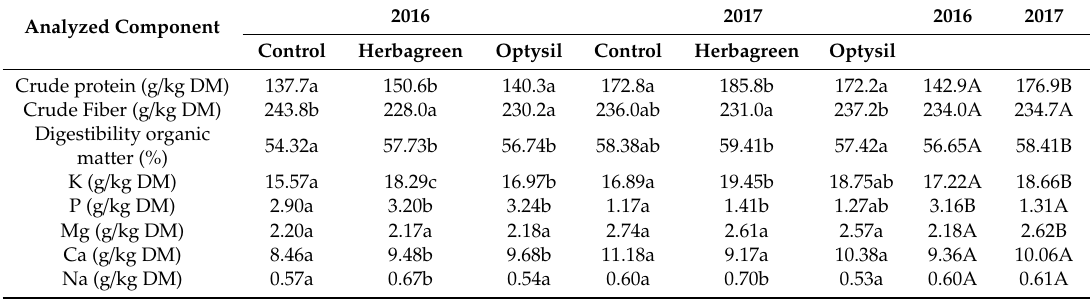
Table 5. Nutritional value of the grass–clover sward depending on the application of fertilizers containing